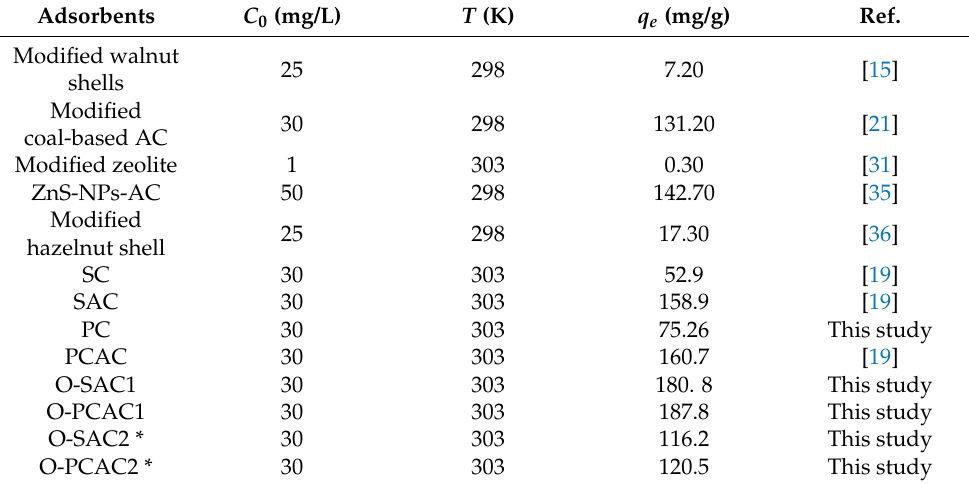
Table 5. Adsorption capacities of